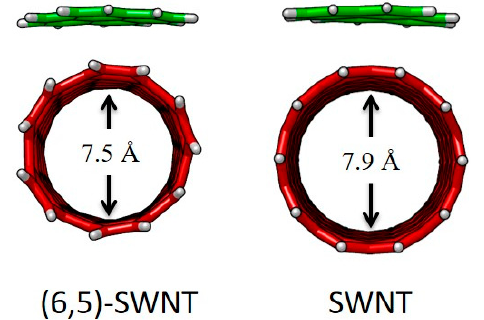
Figure 25. Side view of the supramolecular complex formed by 11 and two types of SWNTs. Carbon atoms of SWNTs are highlighted in red whereas the carbon atoms of pyrene are in green. Hydrogen atoms are depicted in white. Reproduced from [117] with permission from the Royal Society of Chemistry.